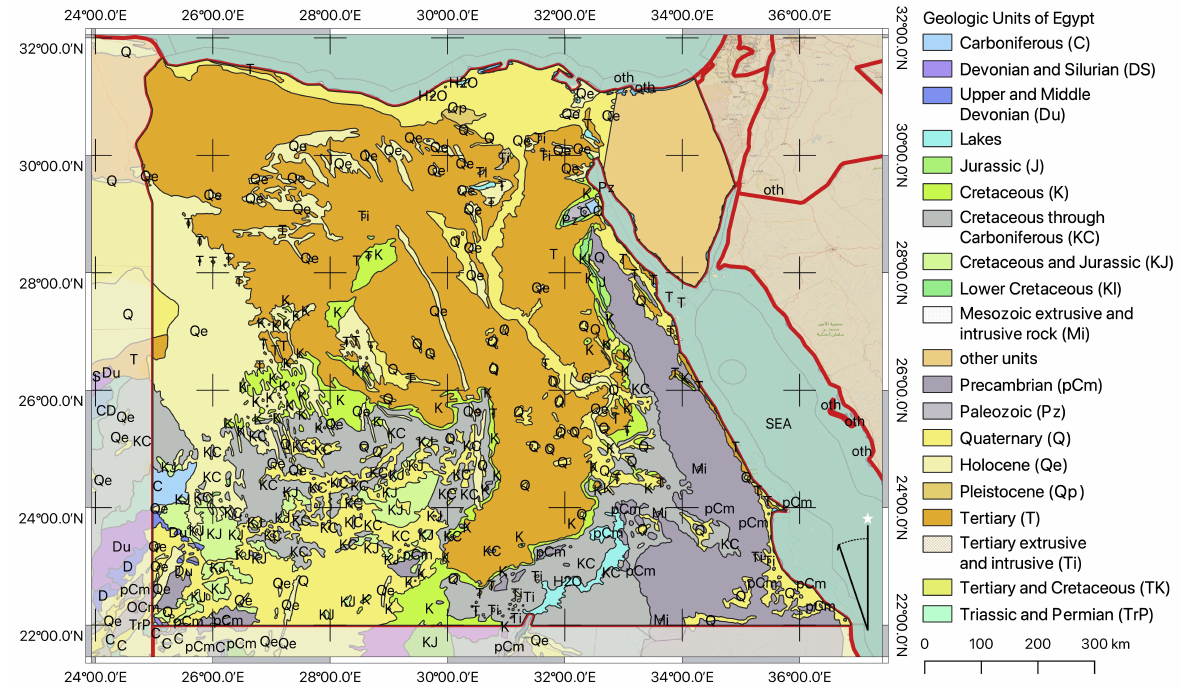
Figure 2. Geologic units of Egypt and the Nile River. Software: QGIS v. 3.2.2. Data source: USGS. Cartography source: